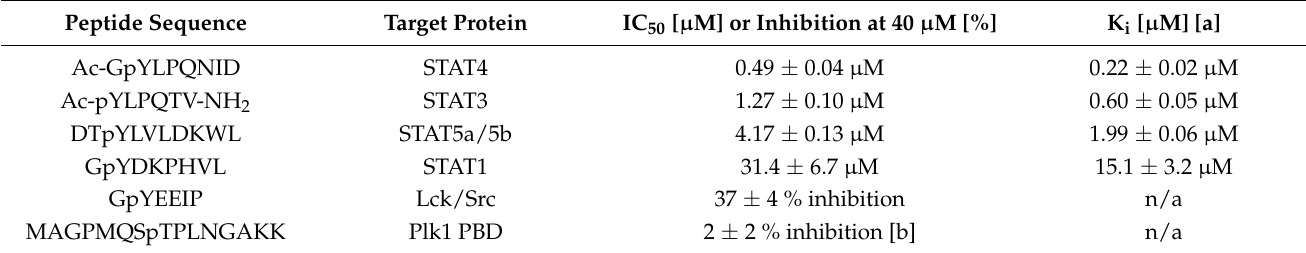
Figure 4. Competitive inhibition of binding between 5-CF-GpYLPQNID and STAT4 (33 nM) by the indicated unlabelled phosphopeptides. Table 1. Summary of peptide inhibition results.